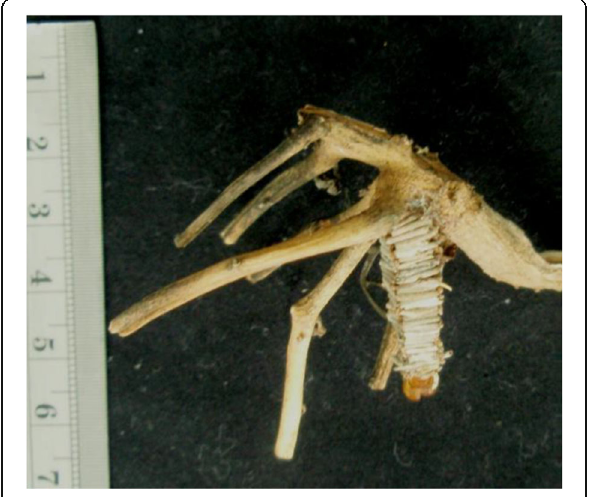
Fig. 2 Sac of male moth after adult emergence showing the tip of pupal exuvium